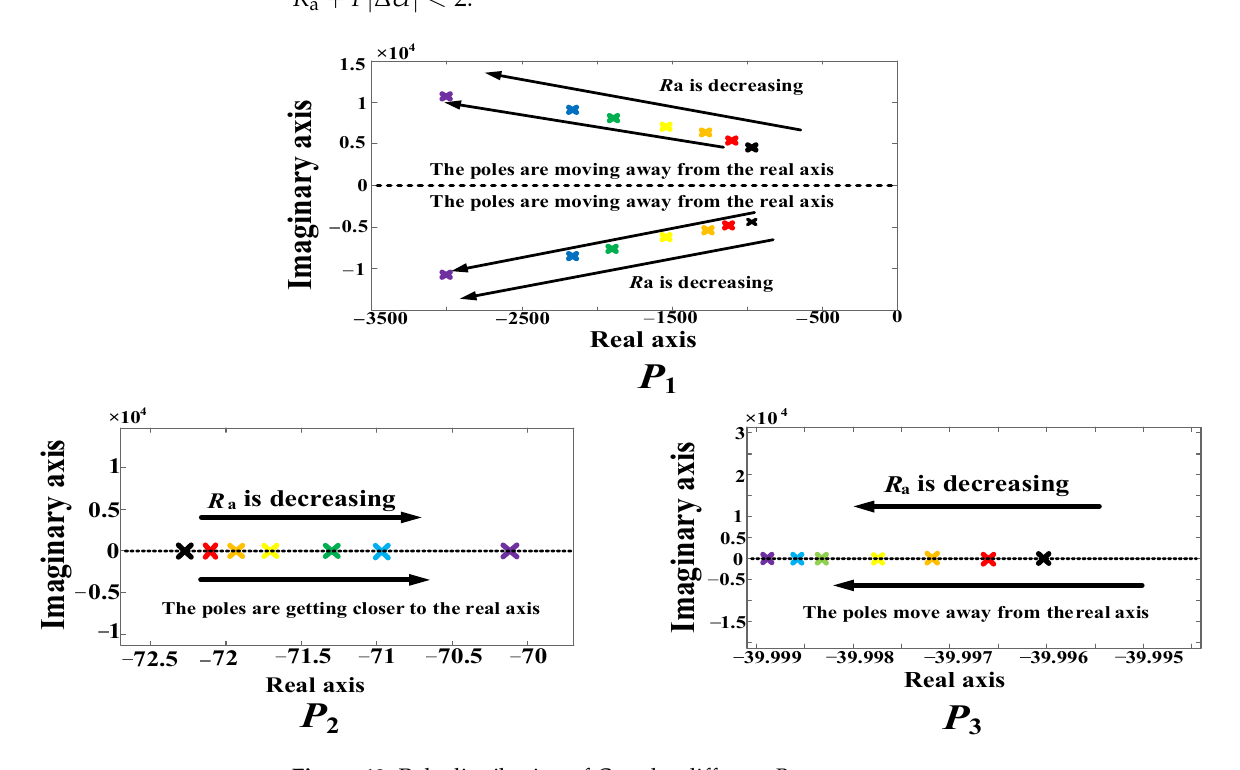
Figure 12. Pole distribution of G under different R a .